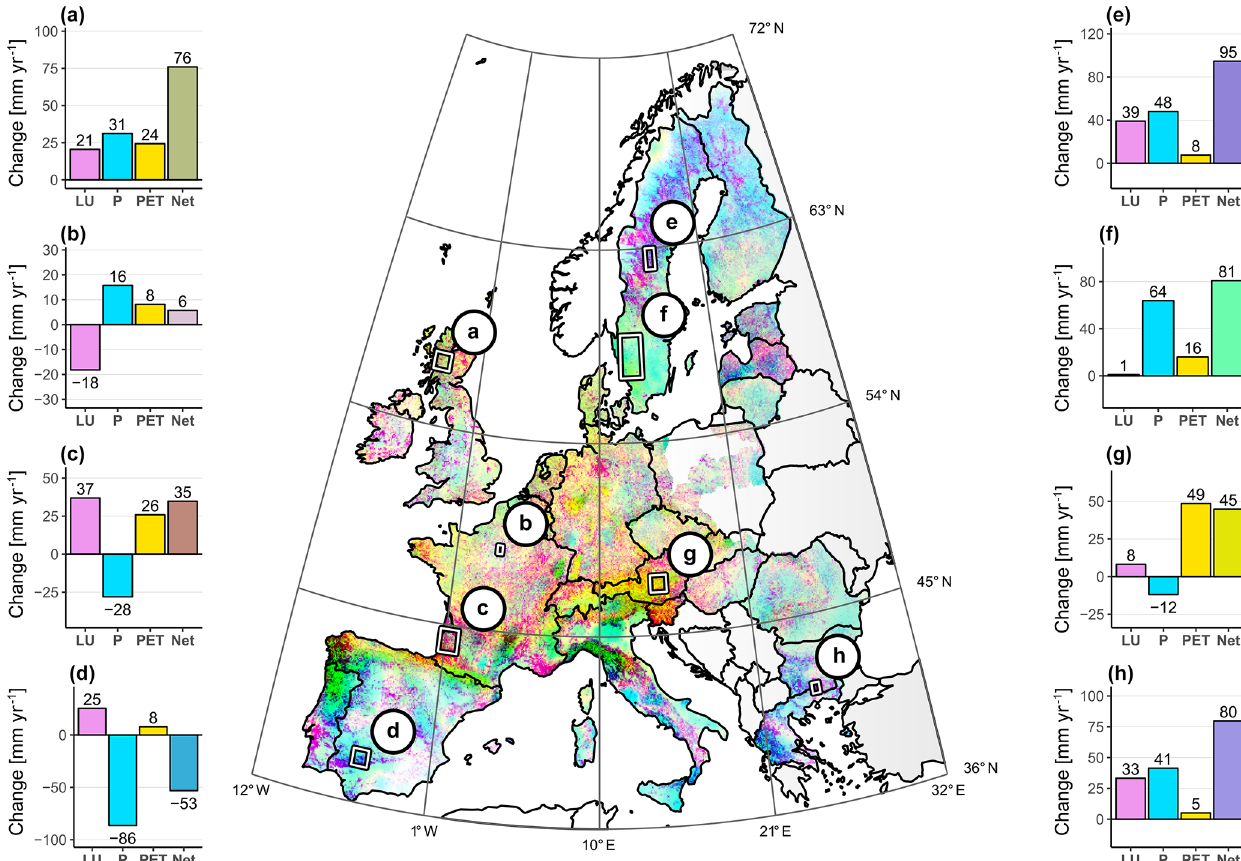
Figure 8. Distribution of the absolute contribution of climate ( P and PET) and land use (LU) changes to changes in evapotranspiration over the period 1960–2010. Colours reflect the relative importance of land use (LU, in magenta or RGB 0, 255, 255), precipitation ( P , in cyan or 255, 0, 255), and PET (yellow, 255, 255, 0). Grey indicates no data. Each contribution is inversely scaled between the 2nd and 98th percentiles over Europe to reflect its relative importance. As a result, white (255, 255, 255) indicates locations where all contributions are below their 2nd percentile, and black (0, 0, 0) indicates locations where all contributions are above their 98th percentile. The side panels show the absolute contributions of LU, P, and PET and the net change for the selected regions. (a) Southern Highlands (Scotland), (b) Paris metropolitan area (France), (c) Landes forest region (France), (d) Seville region (Spain), (e) central Sweden, (f) southern Sweden, (g) Styria region (Austria), and (h) Smolyan Province (Bulgaria). Domain averages are listed in Table